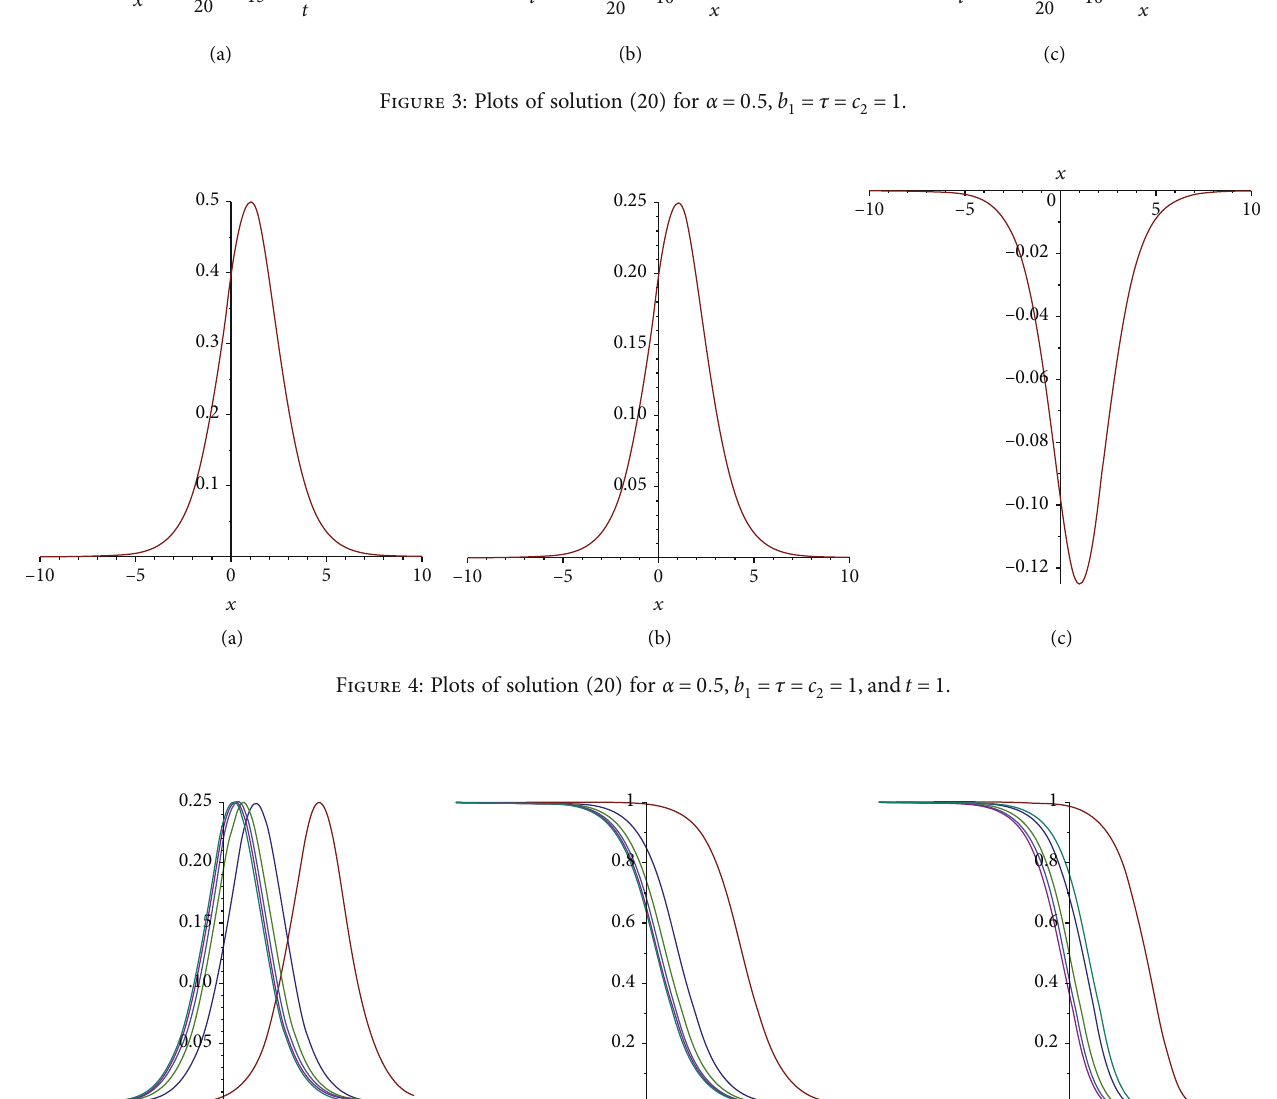
Figure 5: Plots of solution (19) for b